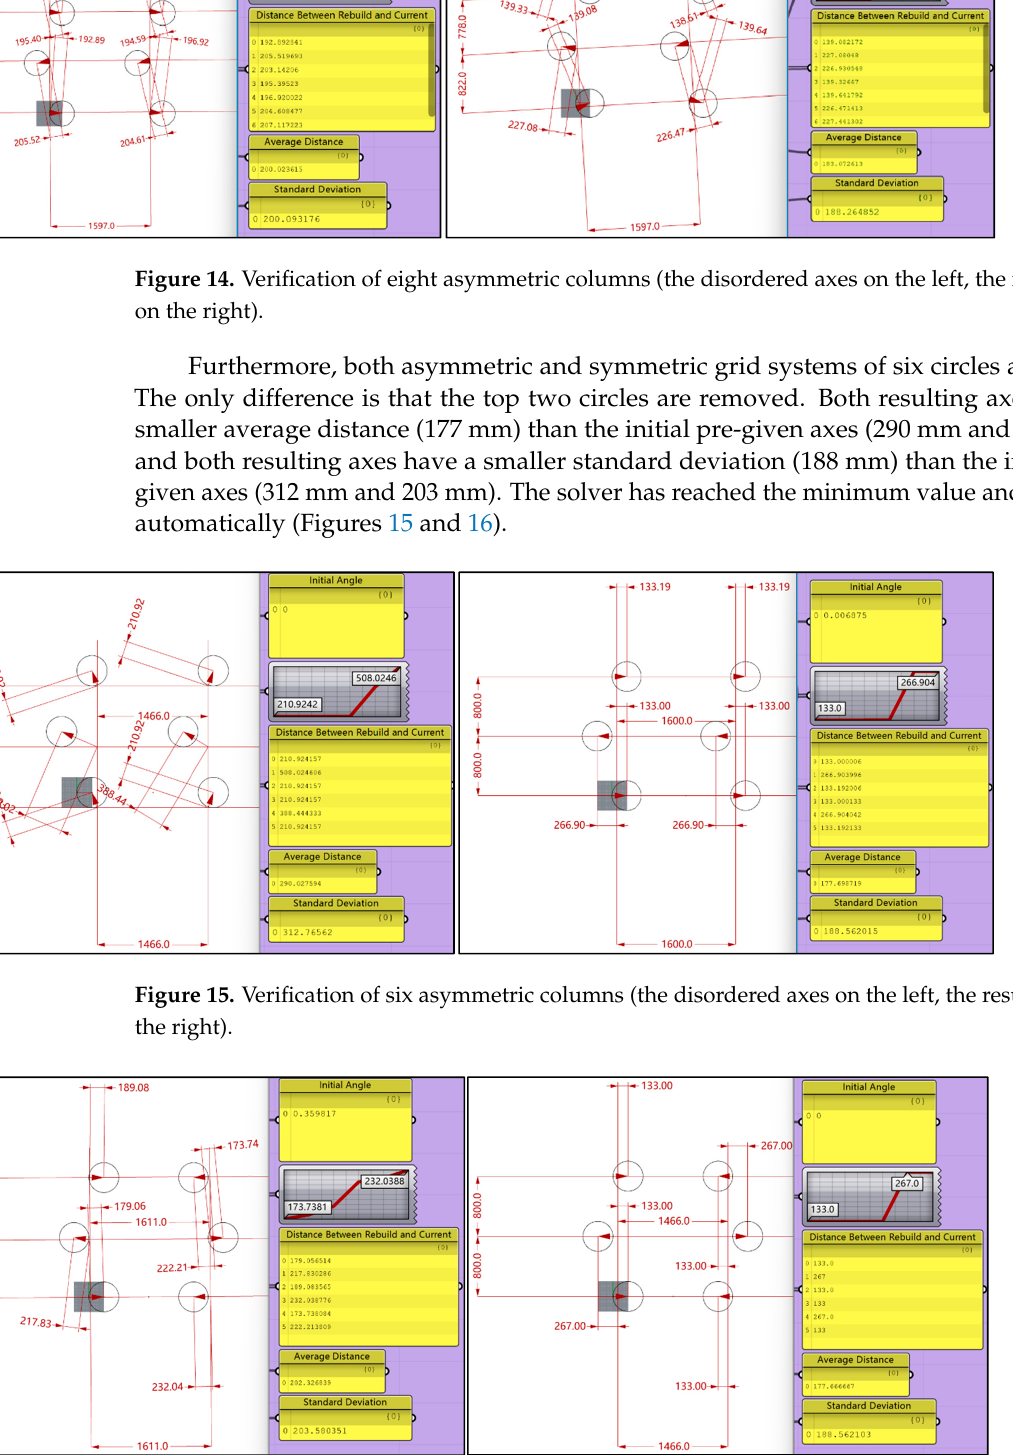
Figure 16. Verification of six symmetric columns (the disordered axes on the left, the result axes on the right).